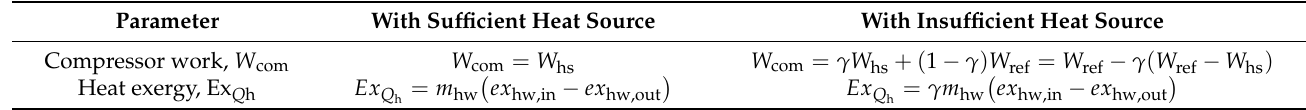
Table 4. Expression of compressor work and heat exergy.